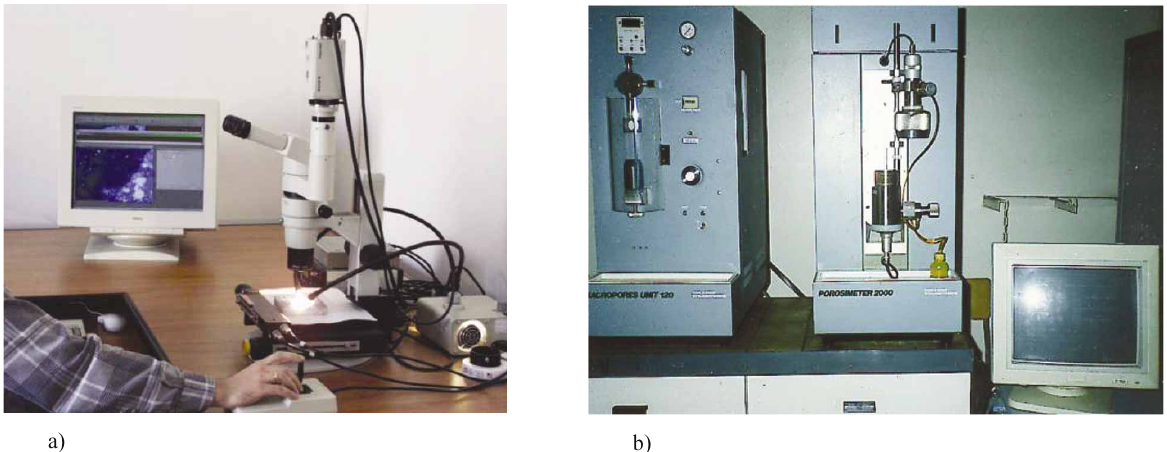
Fig. 2. Rigs for investigating air surface pores in hardened concrete by means of: a) image analyzer; b) mercury porosimeter